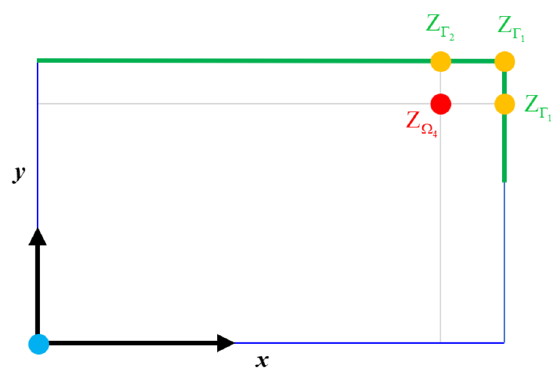
Figure 4. For Example 1: Z Ω ’s segmentation diagram. Figure 4. For Example 1: Z Figure 4. For Example 1: Z (cid:2960) ’s segmentation diagram. (cid:2960) ’s segmentation diagram. Figure 4. For Example 1: Z (cid:2960) ’s segmentation diagram.